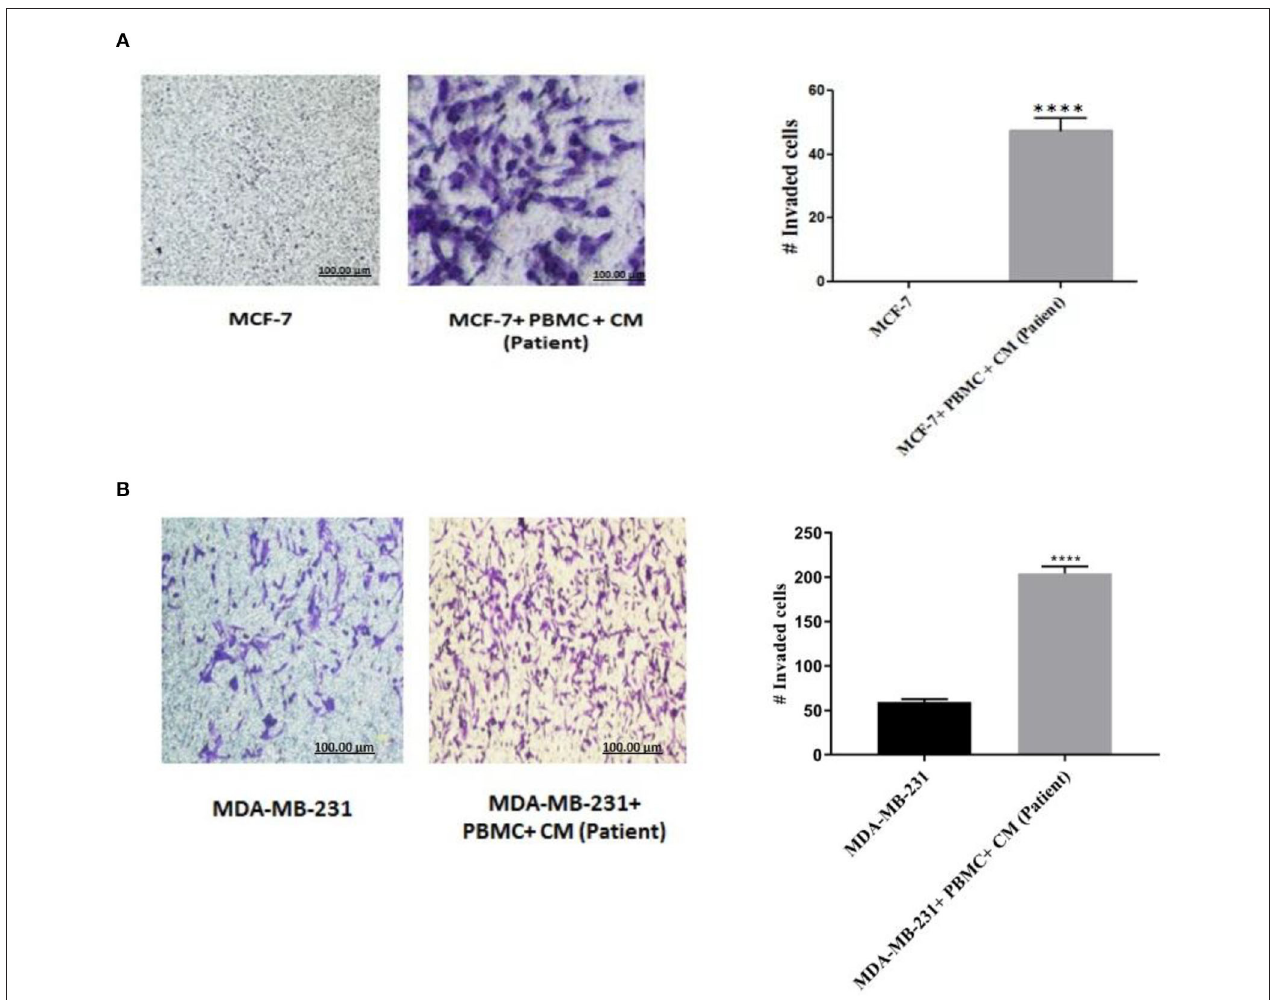
FIGURE 2 | Matrigel invasion assay of (A) MCF-7 and (B) MDA-MB-231 cells after co-culturing with PBMCs in the presence of 50% conditioned media (CM) for 5 days. Results reported as mean ± SEM performed in triplicates, **** p < 0.0001; p- values were obtained using two-tailed Student’s t -tests.